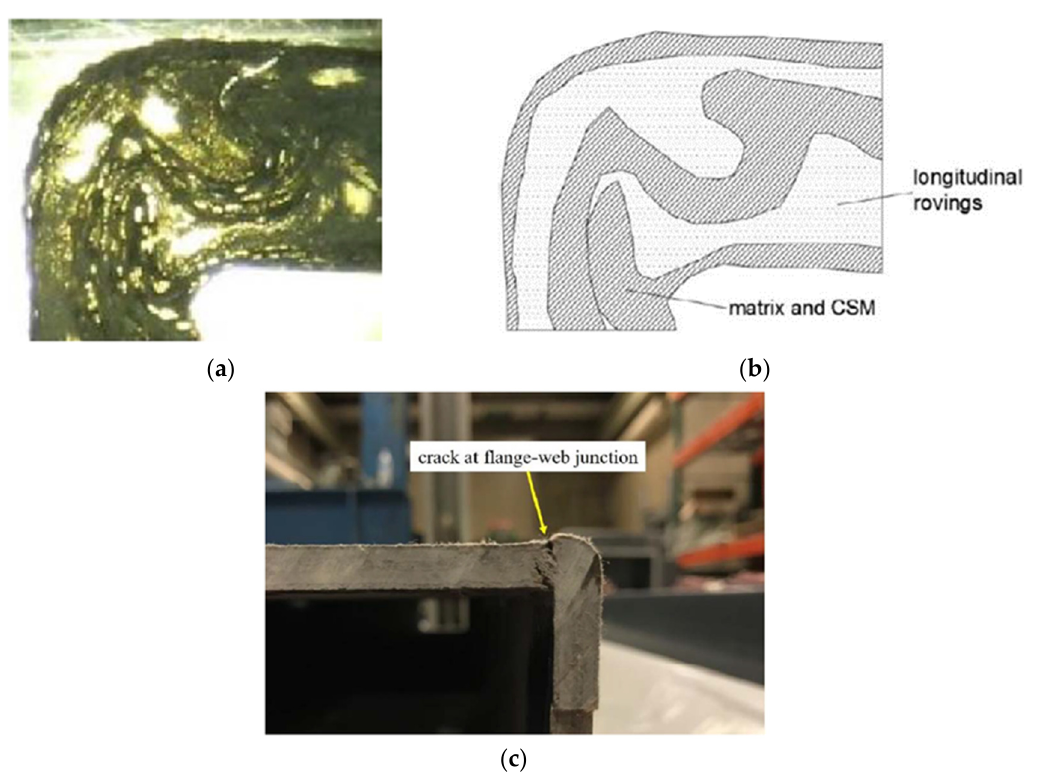
Figure 16. Flange-web junction of hollow box pultruded GFRP beam (102 mm × 152 mm × 6.4 mm): ( a ) image of fibre and matrix architecture, ( b ) schematic of fibre and matrix architecture, and ( c ) crack at the flange-web junction under bending [101].